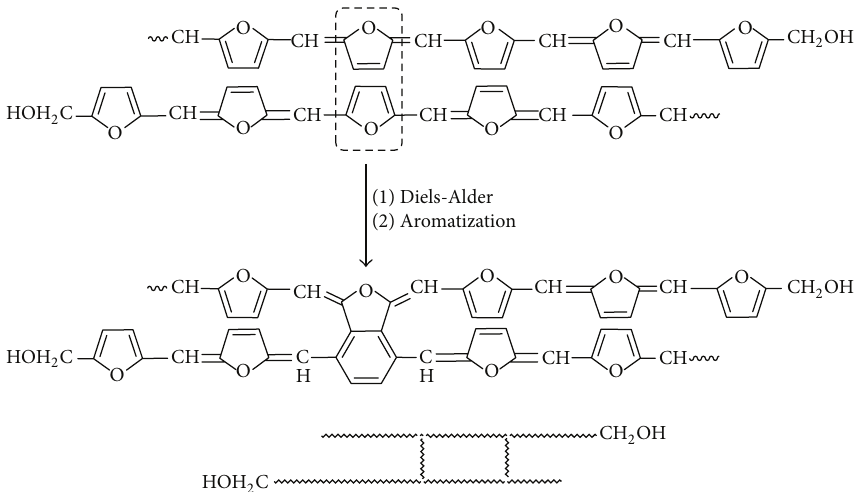
Figure 3: Formation of benzene ring via the Diels-Alder and aromatization reactions joining the two polyfurfuryl alcohol chains.